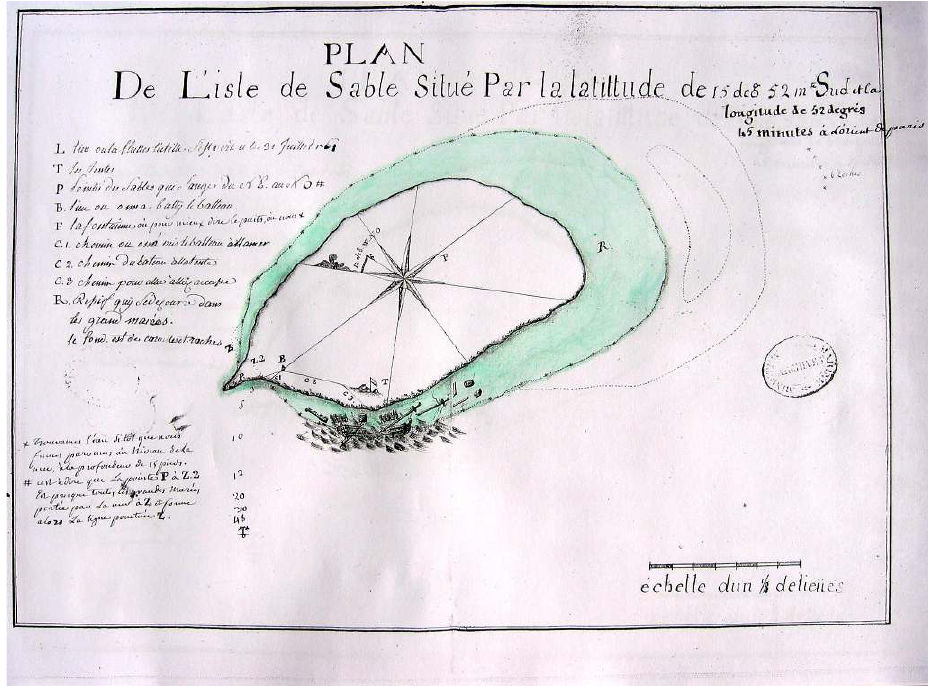
Figure 1. Map of Tromelin Island (in French: île de Sable), Paris, Archives Nationales,